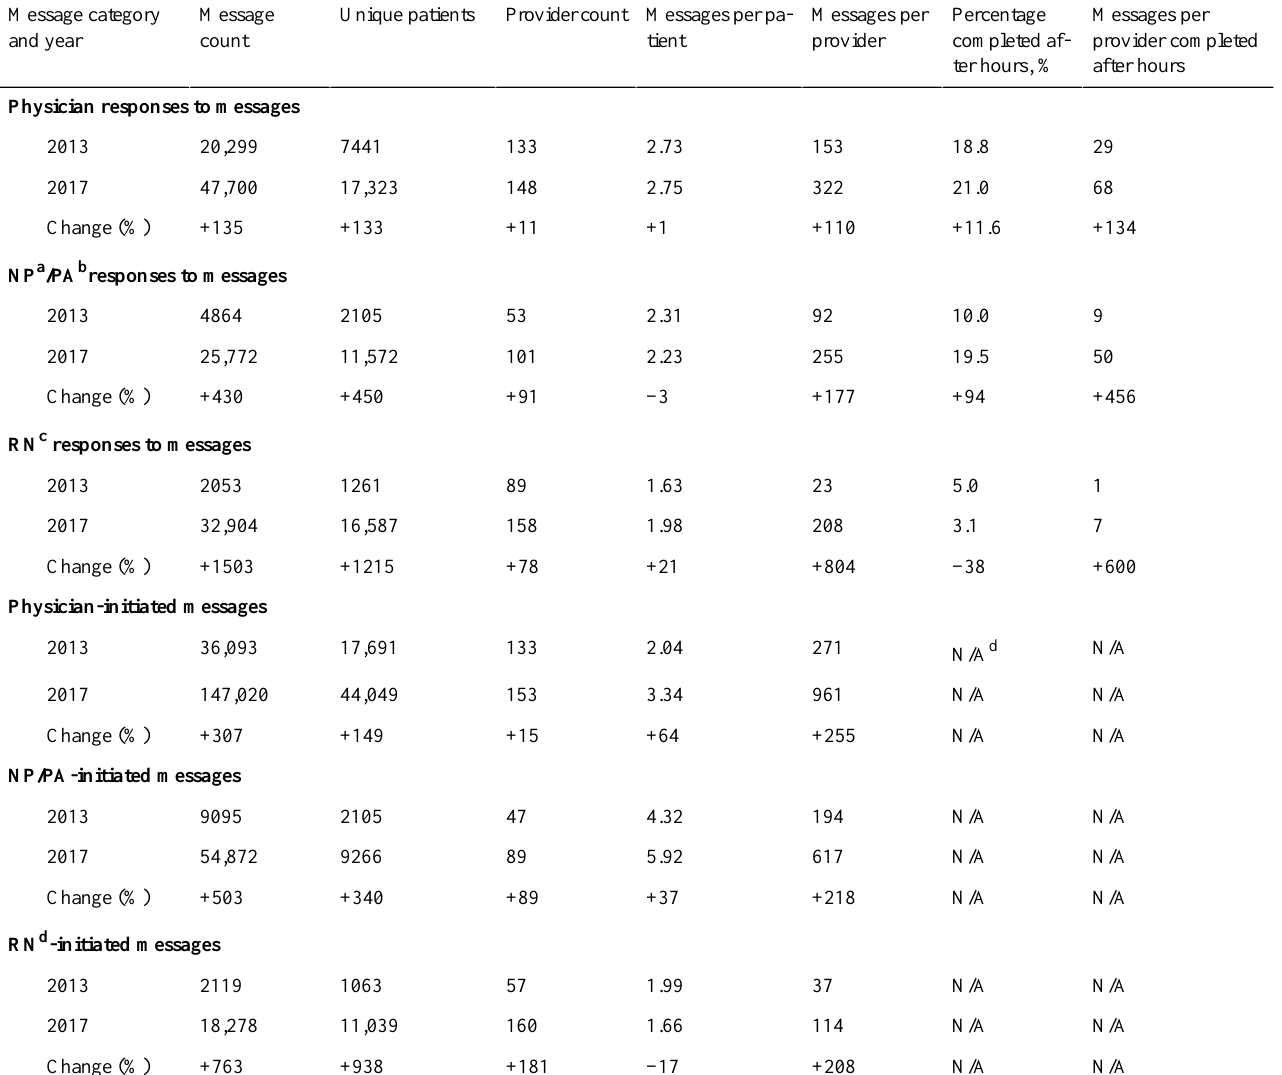
Table 3. Primary care messages.